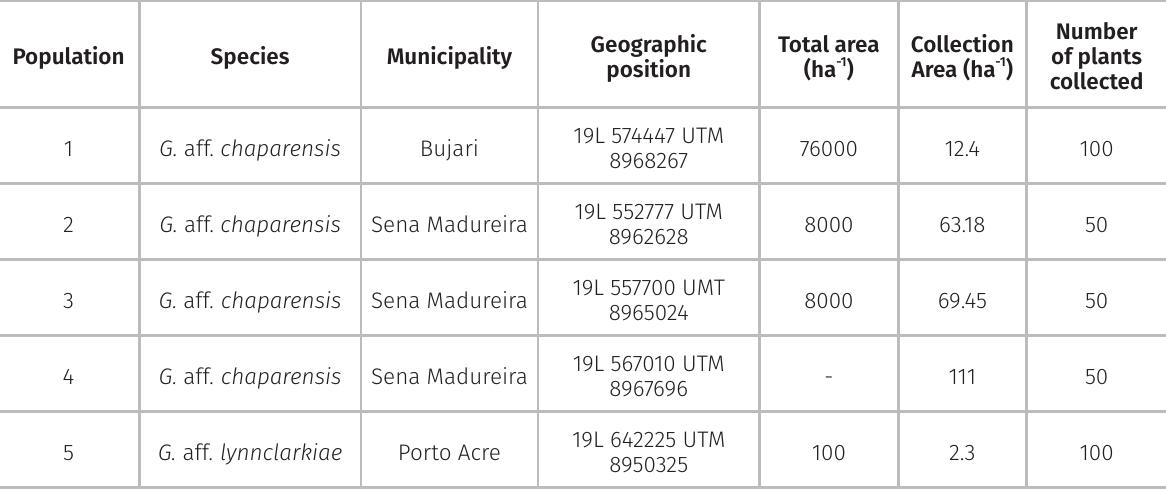
Table I. Characterization of the sample collection areas of the study with the species of Guadua aff. chaparensis and G. aff. lynnclarkiae in the southwest region of the Brazilian Amazon, in the state of Acre.